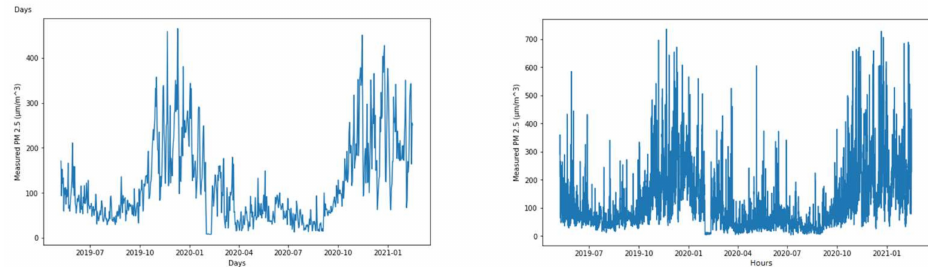
Figure 1. Lahore daily and hourly PM 2.5 concentrations between 2019–2021.